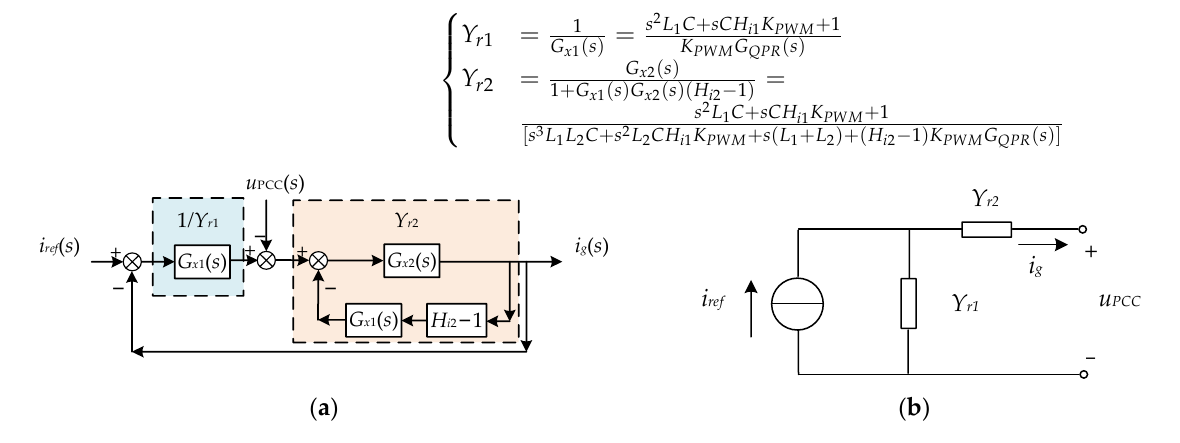
Figure 5. The establishment of the double-decomposed conductance model: ( a ) the double-decomposed conductance small signal model; ( b ) the two-port equivalent model under the double-decomposed conductance.